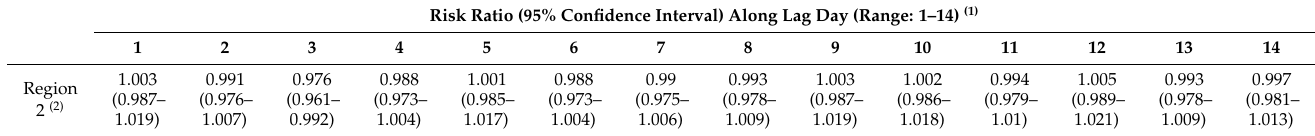
Table 3. Association between DTR and risk of diabetic foot amputation in region 2.